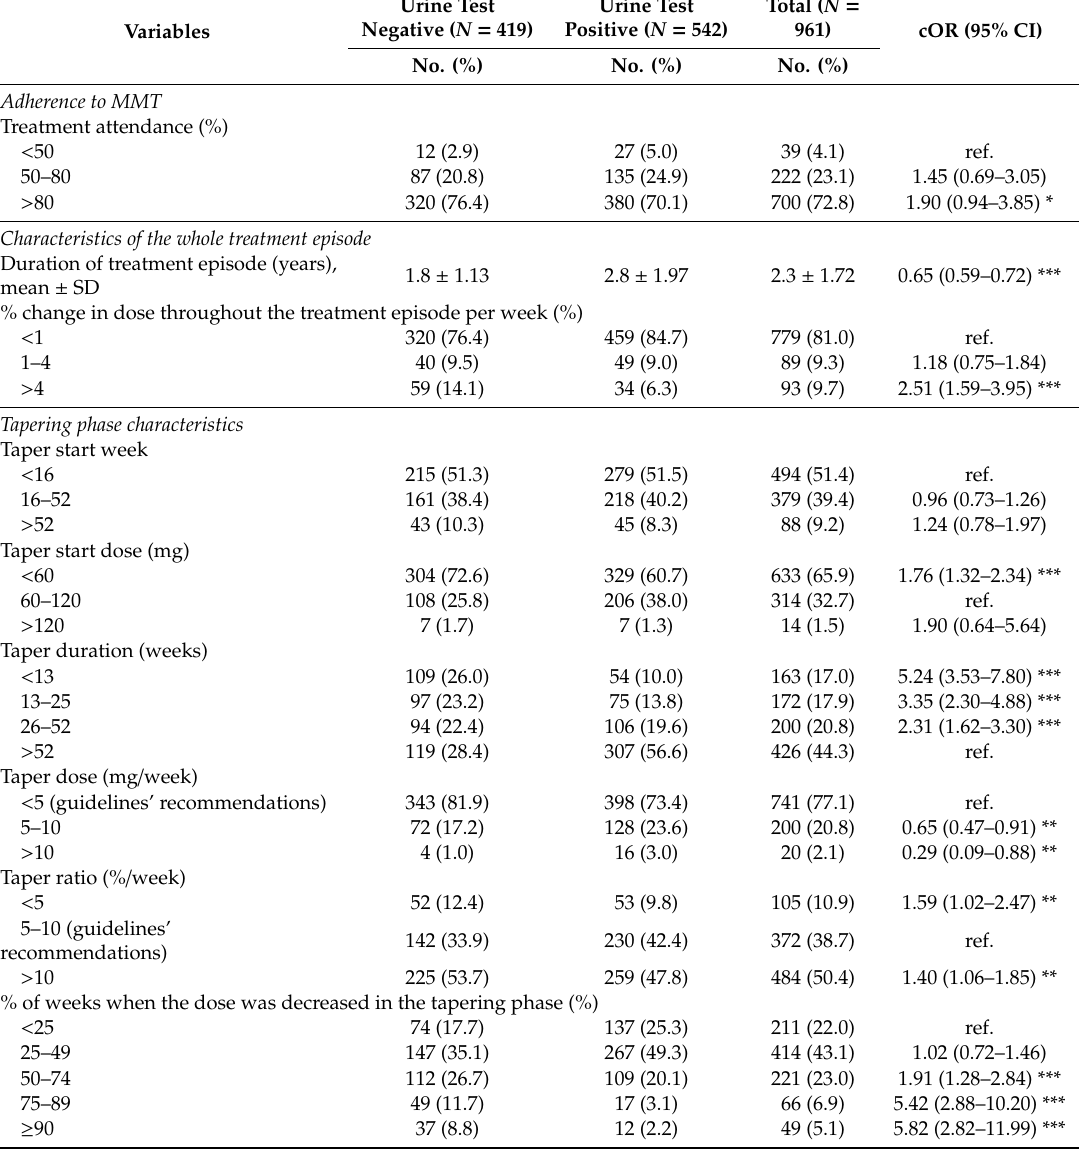
Table 2. Characteristics of each treatment episode which contained a tapering phase and univariable regression results of heroin abstinence (level 1, N =